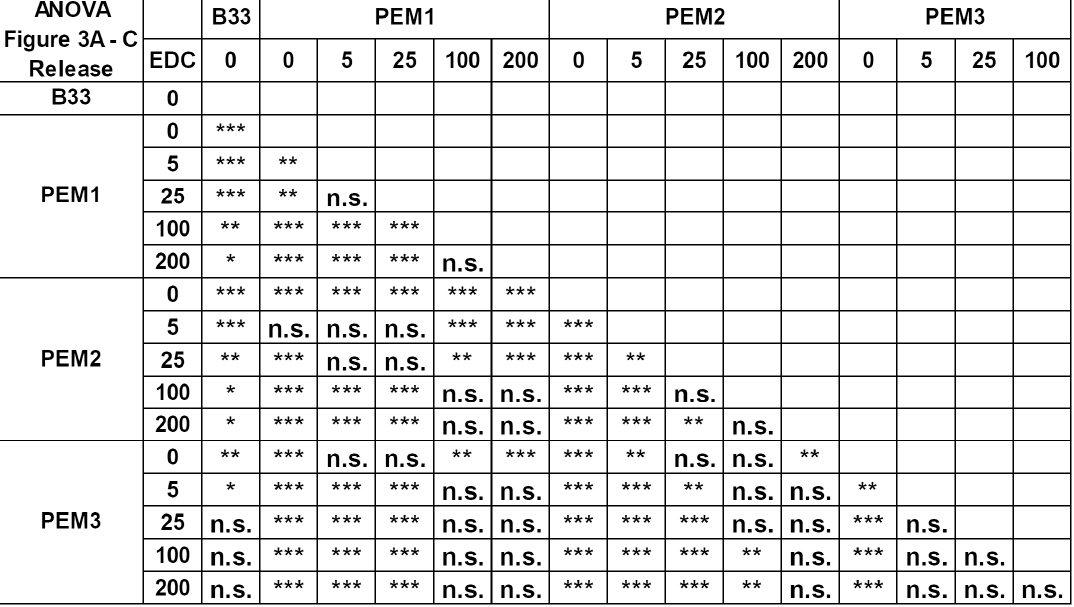
Figure A2. Results of one-way ANOVA for data related to Figure 3D–F; n.s.: not significant; *: p < 0.1; **: p < 0.05; ***: p < 0.001.